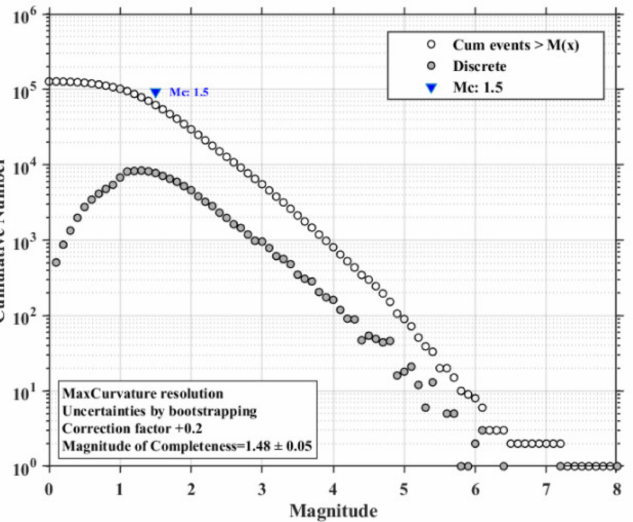
Figure 3. Frequency-magnitude distribution of the seismicity of the Wenchuan-Lushan sequence from 1 January 2000 to 1 January 2019.